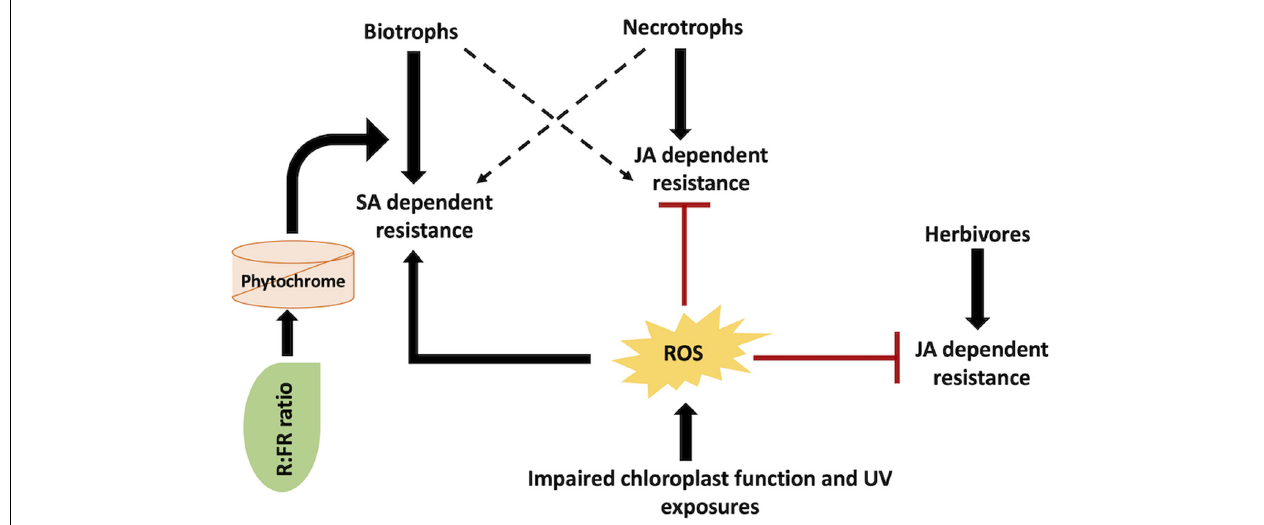
FIGURE 4 | SA/JA mediated cross-talk in light signaling and defense responses against different pathogenic agents: various biotic agents activate different mechanisms. Reactive oxygen species (ROS), salicylic acid (SA), and jasmonic acid